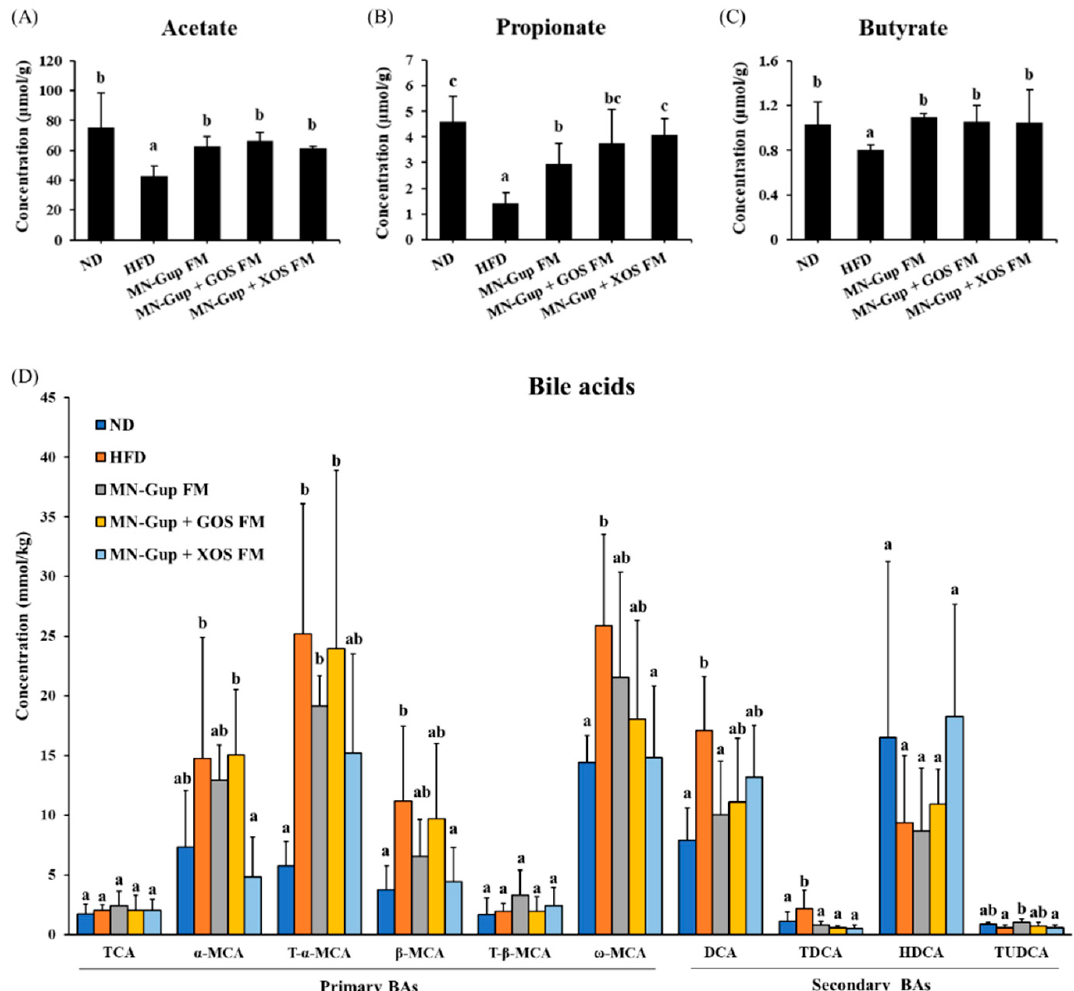
Figure 5. Effects of fermented milk containing MN-Gup or MN-Gup-based synbiotics on the